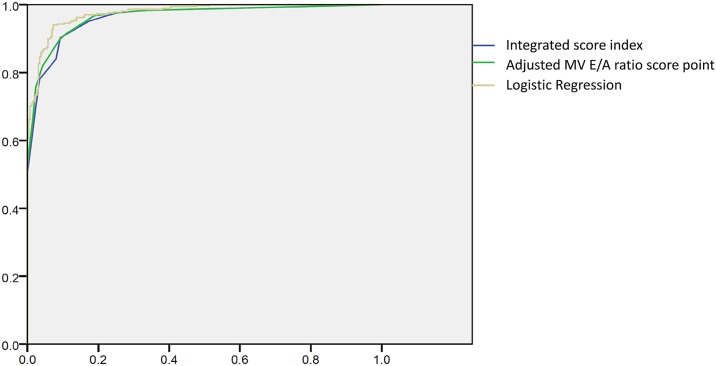
The AUROC of the integrated score index used to predict any diastolic dysfunction (U.S. grades 1, 2, and 3) was 0.962, the AUROC with the criteria of MV E/A Doppler <1 with a score of 2 was 0.965, and the AUROC of the method suggested by the logistic regression was 0.970 (blue line: integrated score index; green: adjusted MV E/A score point; yellow line: logistic regression).